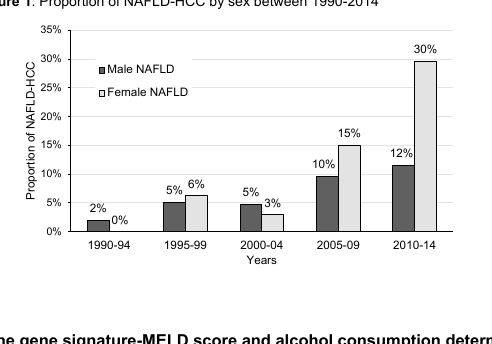
Figure 1 : Proportion of NAFLD-HCC by sex between